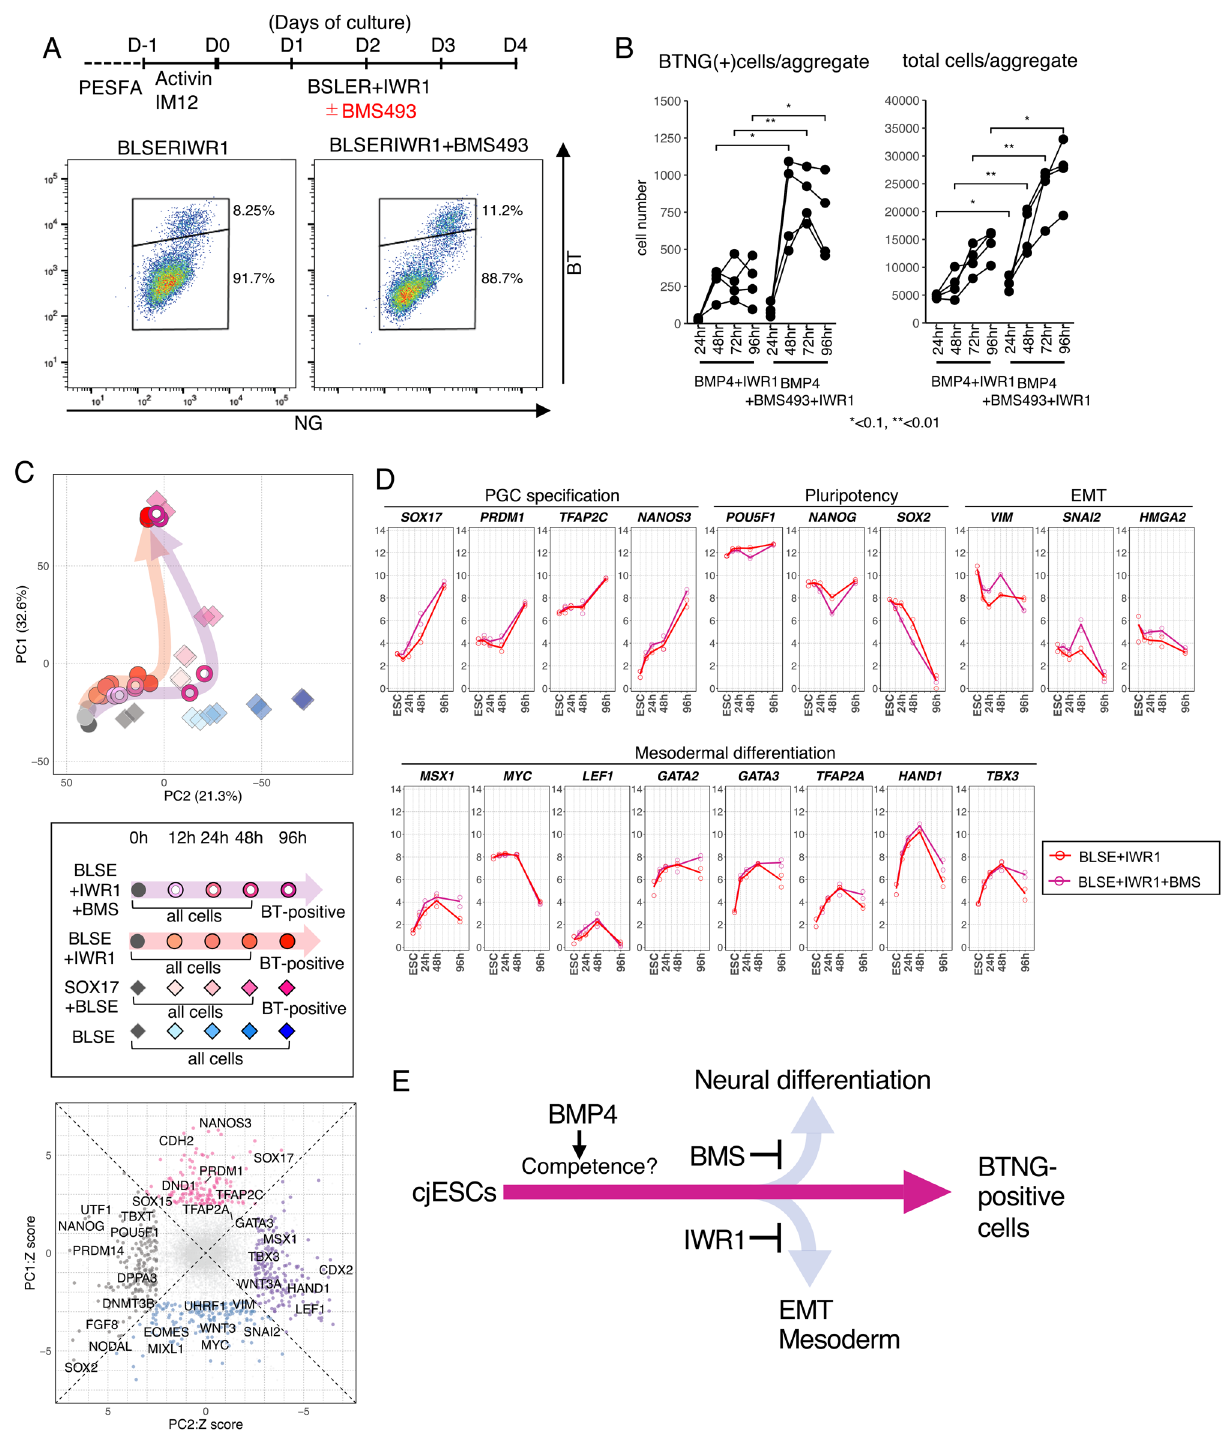
Figure 4. A robust induction of BTNG-positive cells with IWR1 and BMS493. ( A ) A robust induction of BTNG-positive cells with BLSE + IWR1 + BMS. The top panel shows the schematic time course of the BTNG-positive cell induction with IWR1 and BMS493 after preculture, and the bottom panel is a representative FACS plot of cells at day 4 of induction. ( B ) The numbers of cells in the induction of BTNG-positive cells. Shown are the numbers of BTNG-positive cells (left) and total cells per aggregate (right). The plots were based on experiments repeated 4 times. Each line traces values obtained in a separate series of experiments. ( C ) Comparison of the differentiation trajectories under the BLSE + IWR1 + BMS condition. The top plot shows the PCA of cjESCs and derivatives cultured under the condition shown below. The bottom scatterplot shows the Z scores of the genes for the PC1 and 2 axes. Genes with > 2.5 SDs (690 genes) are shown. ( D ) Expression dynamics of representative genes during the induction of BTNG-positive cells under the BLSE + IWR1 + BMS condition in comparison with those of representative genes during the induction of BTNG-positive cells with BLSE + IWR1. Graphs show the expression levels of genes involved in PGC specification, pluripotency, EMT and mesodermal differentiation. Each plot is based on duplicated RNA-seq analyses. The mean values are connected by a line. The analysis was performed using the common genes between marmosets and humans (15,755 genes). ( E ) A schematic diagram of signaling effects on the differentiation from cjESCs to BTNG-positive